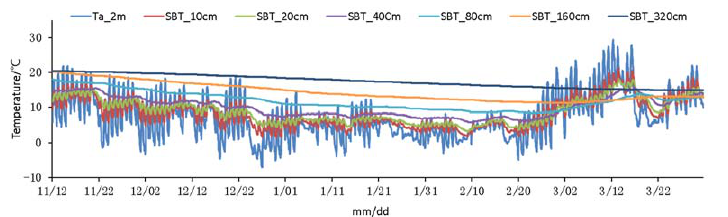
Figure 4. Variations of hourly air temperature and subsurface temperature at Hefei station from 11 December 2021 to 30 March 2022 (Ta_2m represents air temperature at 2 m; SBT_10 cm, SBT_20 cm, SBT_40 cm, SBT_80 cm, SBT_160 cm, SBT_320 cm represent subsurface temperature at 10 cm, 20 cm, 40 cm, 80 cm, 160 cm and 320